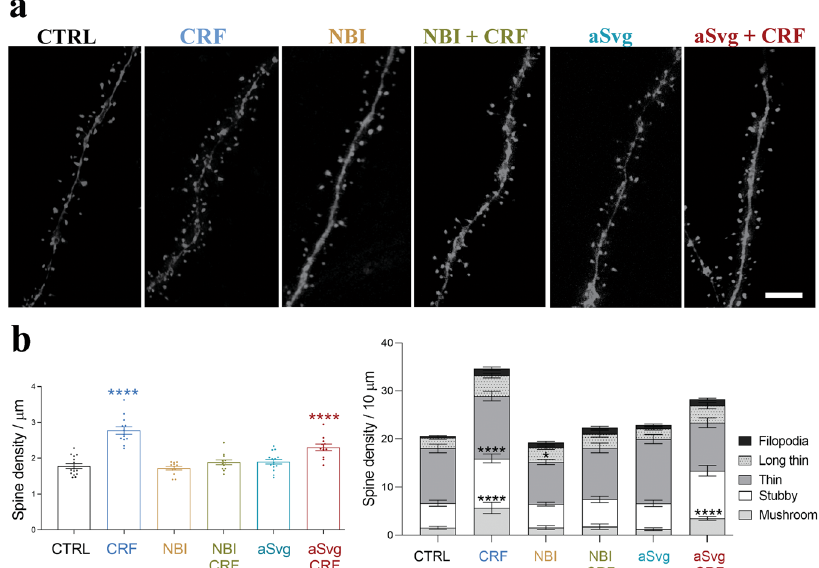
Fig. 2 Short-term CRF application increases pyramidal cell spine density and maturation ex vivo. a Spines on CA1 PC dendrites fi lled with Alexa 568 using: no treatment (CTRL), only 100 nM CRF for 20 min, selective CRF-R1 antagonist NBI (1.2 μ M, NBI), combined NBI and CRF (NBI + CRF), selective CRF-R2 antagonist aSvg (150 nM, aSvg) and combined aSvg and CRF (aSvg + CRF) application. Scale bar = 5 µm. b, c Quanti fi cation of spine densities ( b , shown as mean ± SEM, CTRL; N = 3 animals, n = 15 cells; CRF: N = 5, n = 13; NBI: N = 4, n = 12; NBI + CRF: N = 5, n = 12; aSVG: N = 5, n = 15; aSVG + CRF: N = 4, n = 9; one-way ANOVA with Dunnett ’ s multiple comparisons test (F = 21.25). * p < 0.05, **** p < 0.0001), and type ( c , shown as mean ± SEM; two-way ANOVA with multiple comparisons (F = 21.25). * p < 0.05, *** p < 0.005, **** p < 0.0001) using aforementioned